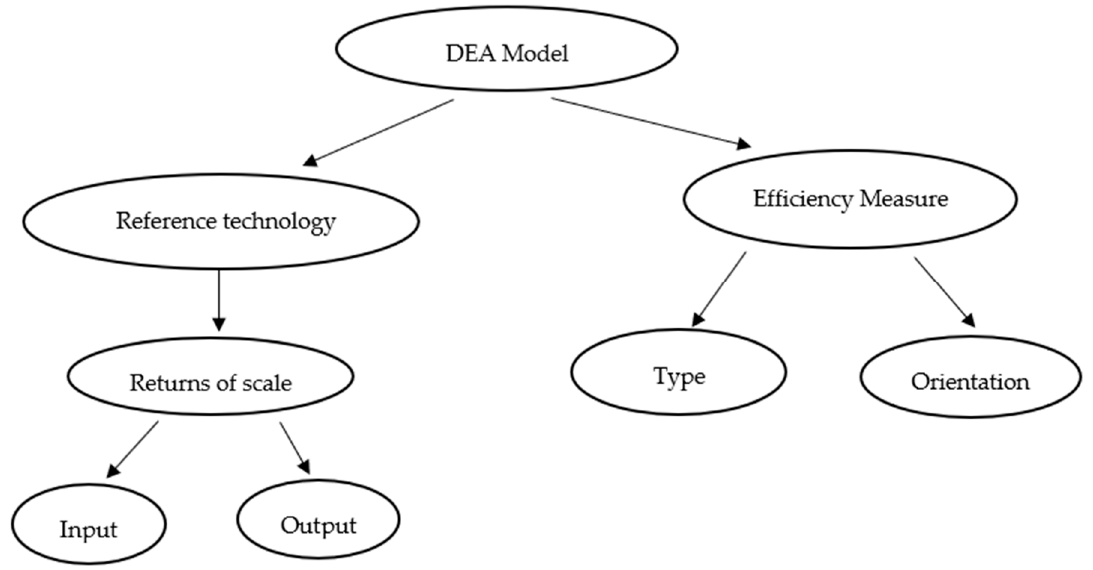
Figure 1. The operating system of a data envelopment analysis (DEA) model.